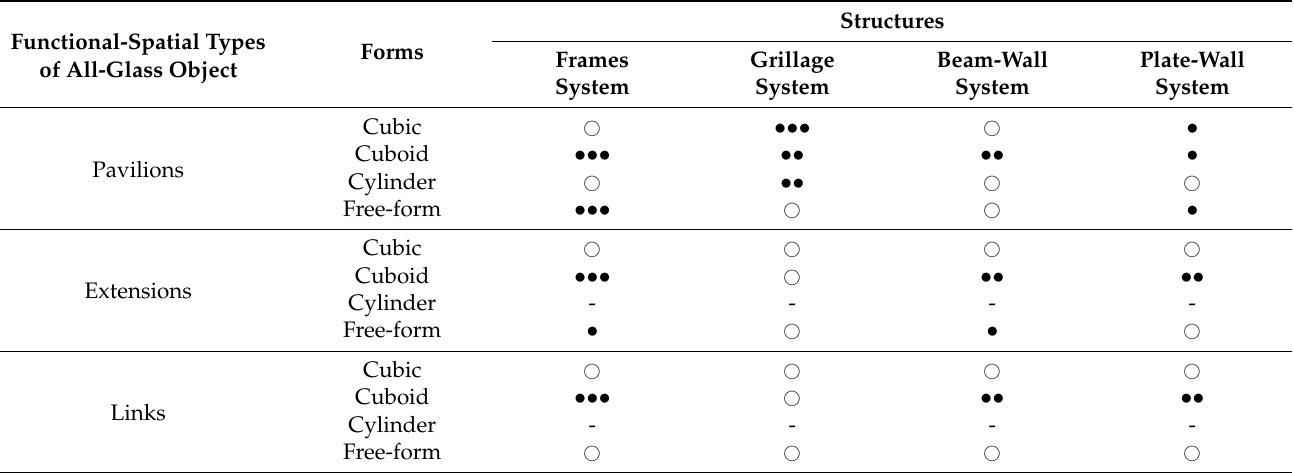
Table 4. Relationship between the structural systems and the functional-spatial, the forms, and the function